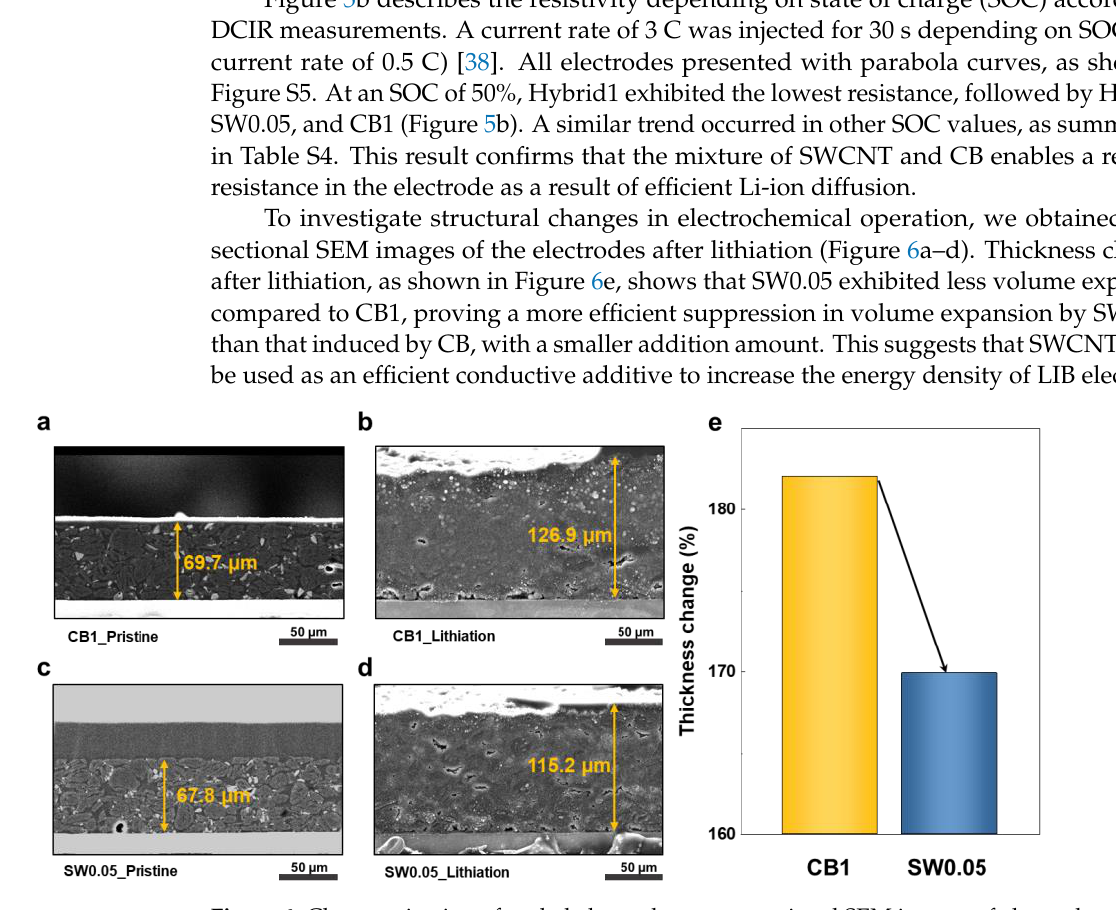
Figure 6. Characterization of cycled electrodes: cross-sectional SEM images of electrodes. Pristine electrodes with ( a ) CB 1 and ( c ) SW0.05 additives. Lithiation electrode with ( b ) CB1 and ( d ) SW0.05 additive. ( e ) Bar image of electrode thickness change.